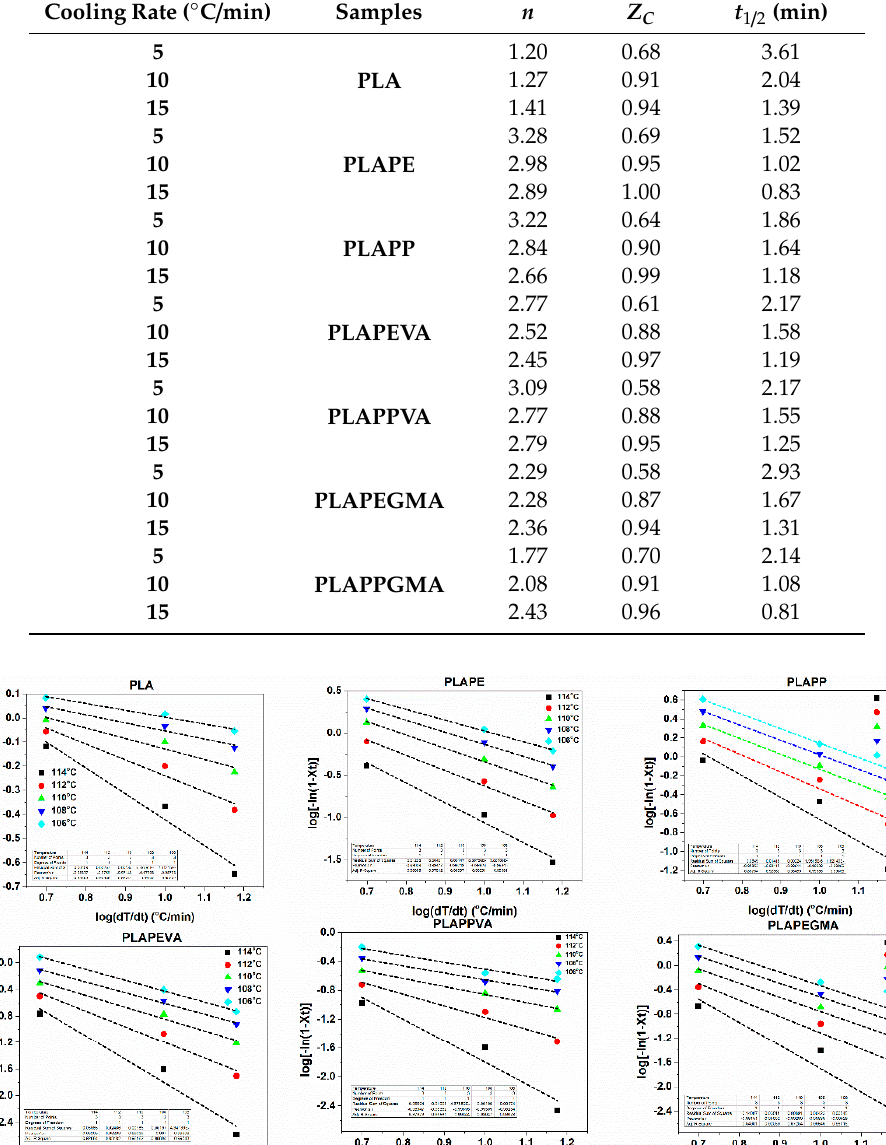
Table 3. Crystallization kinetic parameters at various cooling rates for the various PLA / POEs based on the Avrami model.